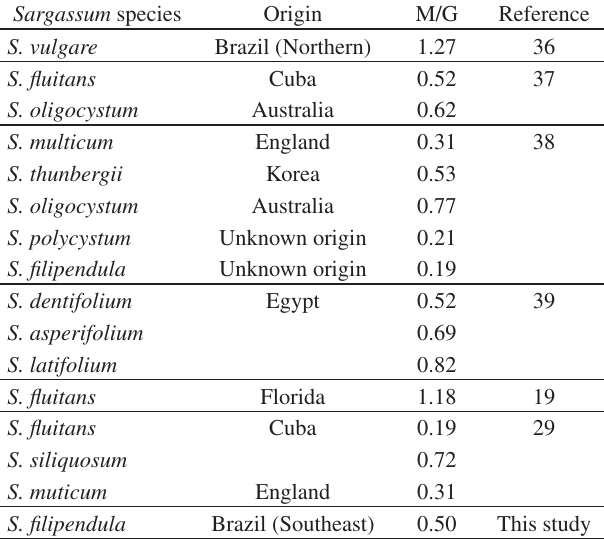
Table 2. M/G ratio of alginate materials extracted from different Sargassum species. Sargassum species